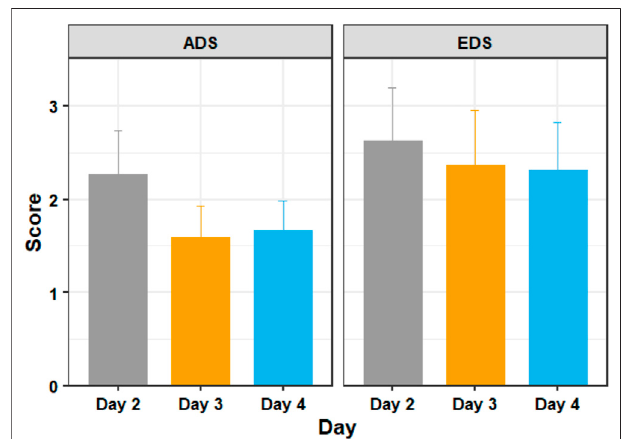
FIGURE 6 | The average discomfort score (ADS) and ending discomfort score (EDS) of participants in days 2, 3, and 4 of adaptation training. Figure shows mean and standard